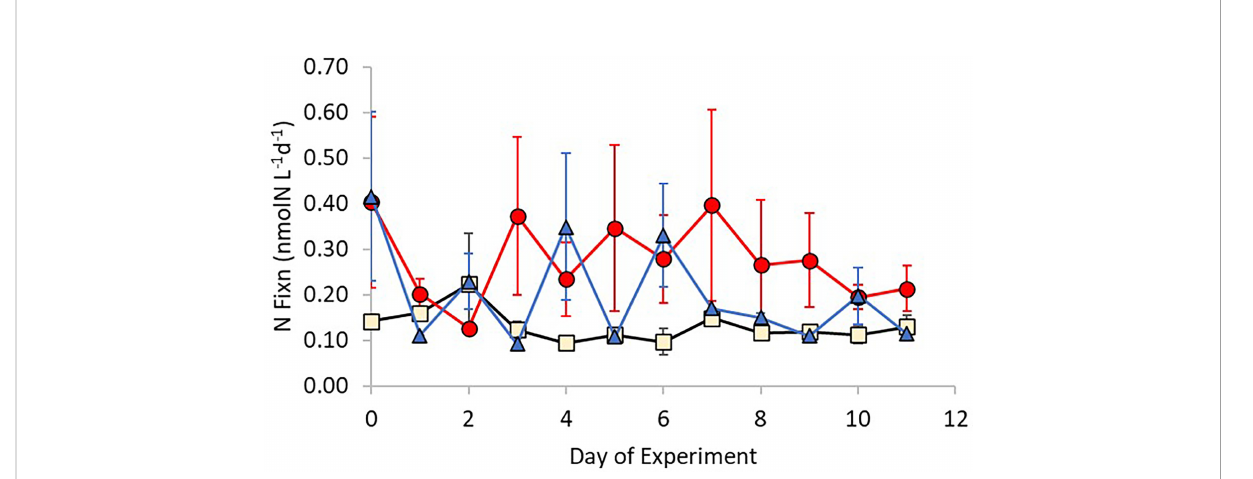
FIGURE 2 Changes in nitrogen fi xation rates over time for each treatment (Control – Beige; +Ag + – blue; +AgNP – red). Error bars show ± 1 standard deviation of the